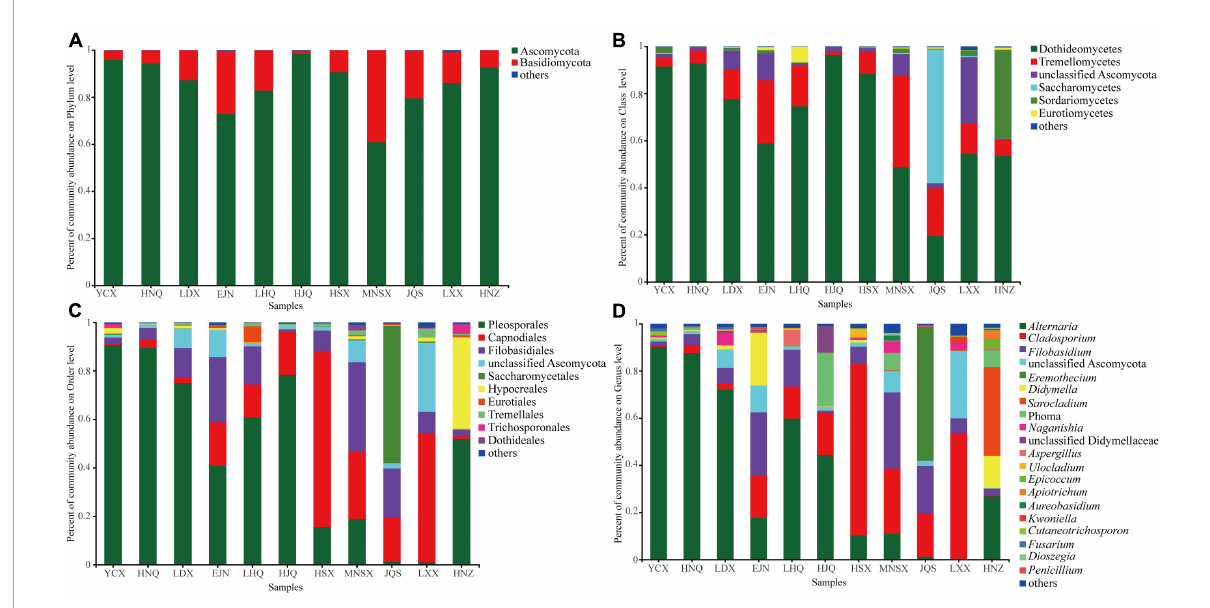
FIGURE3 Composition of endophytic fungal community of S. alopecuroides in different areas. (A) Phylum level, (B) class level, (C) order level, and (D) genus level.